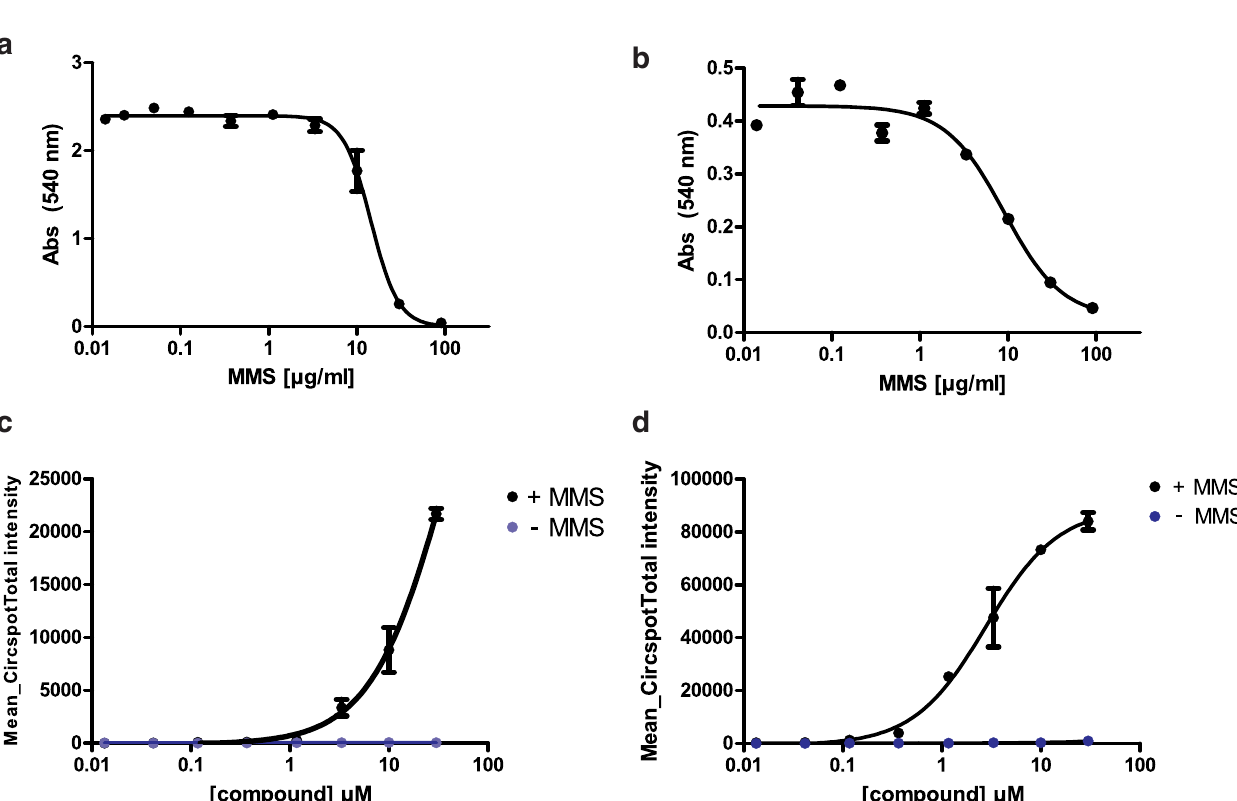
Figure 4. PAR chain detection in different cell lines. ( a ) MEFs and ( b ) SCLC H1048 treated with MMS were fixed and stained with sulforhodamine B (SRB) after 72 h. ( c ) MEFs and ( d ) H1048 cells show a dose-dependent increase in PAR chains after MMS